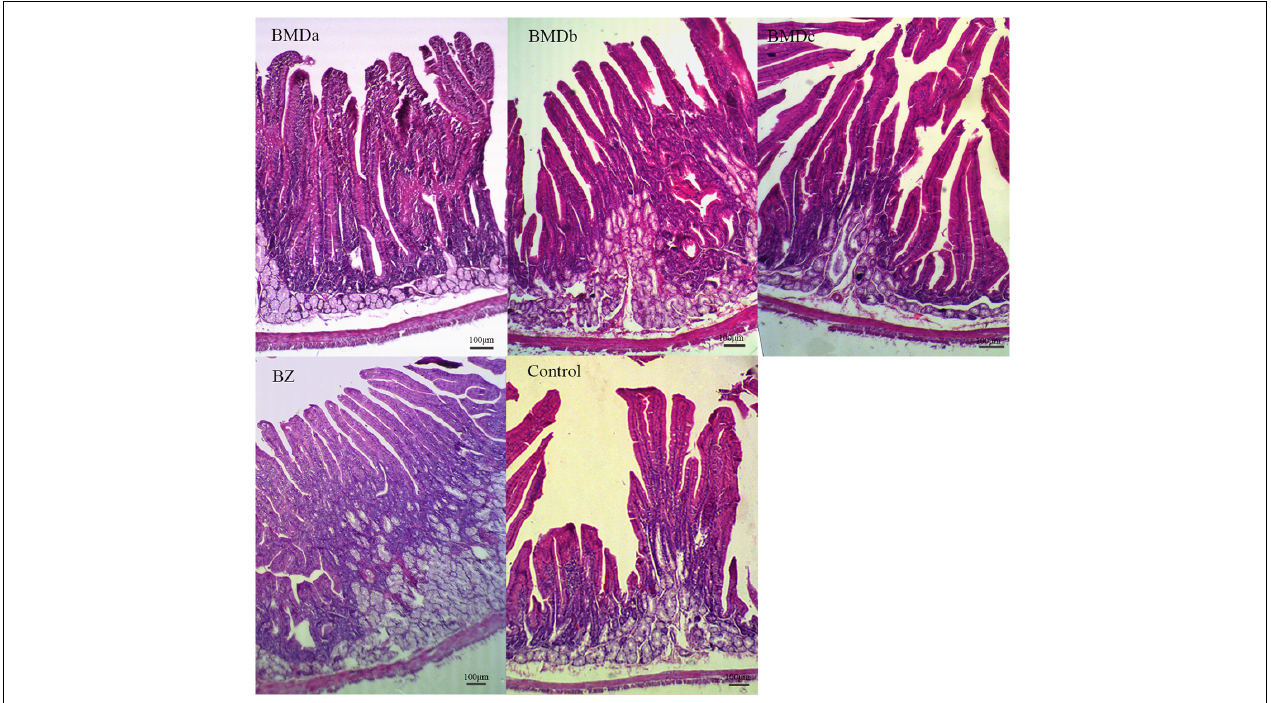
FIGURE 1 | Effect of BMD on the morphology of duodenum in weaned